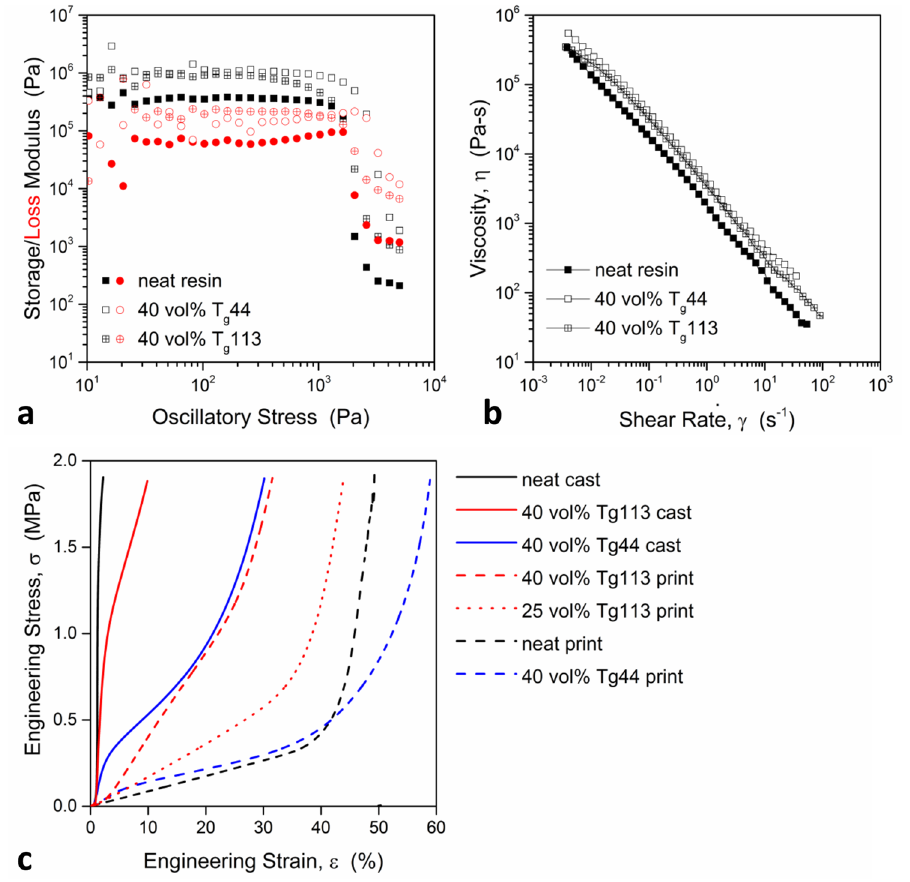
Figure 2. Effect of microballoons on ( a ) rotational oscillatory response, ( b ) continuous flow behavior of the ink, and ( c ) response to compressive loading of the cast and printed